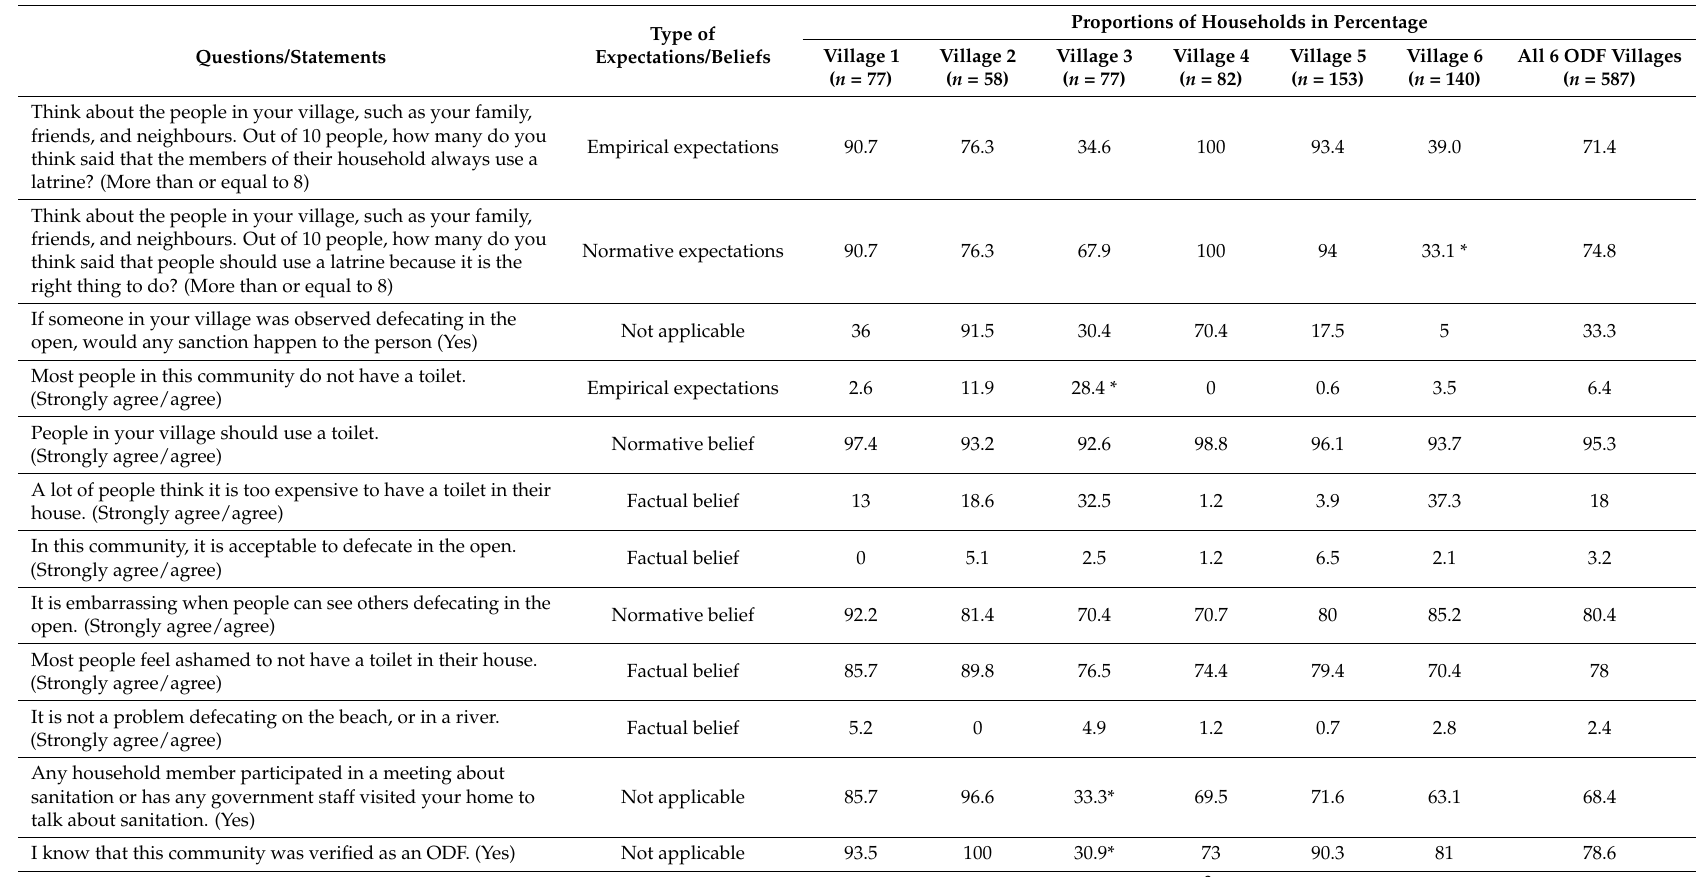
Table 2. Village-Level Social Norms around Latrine Use Behaviour in six Open Defecation Free (ODF) Verified